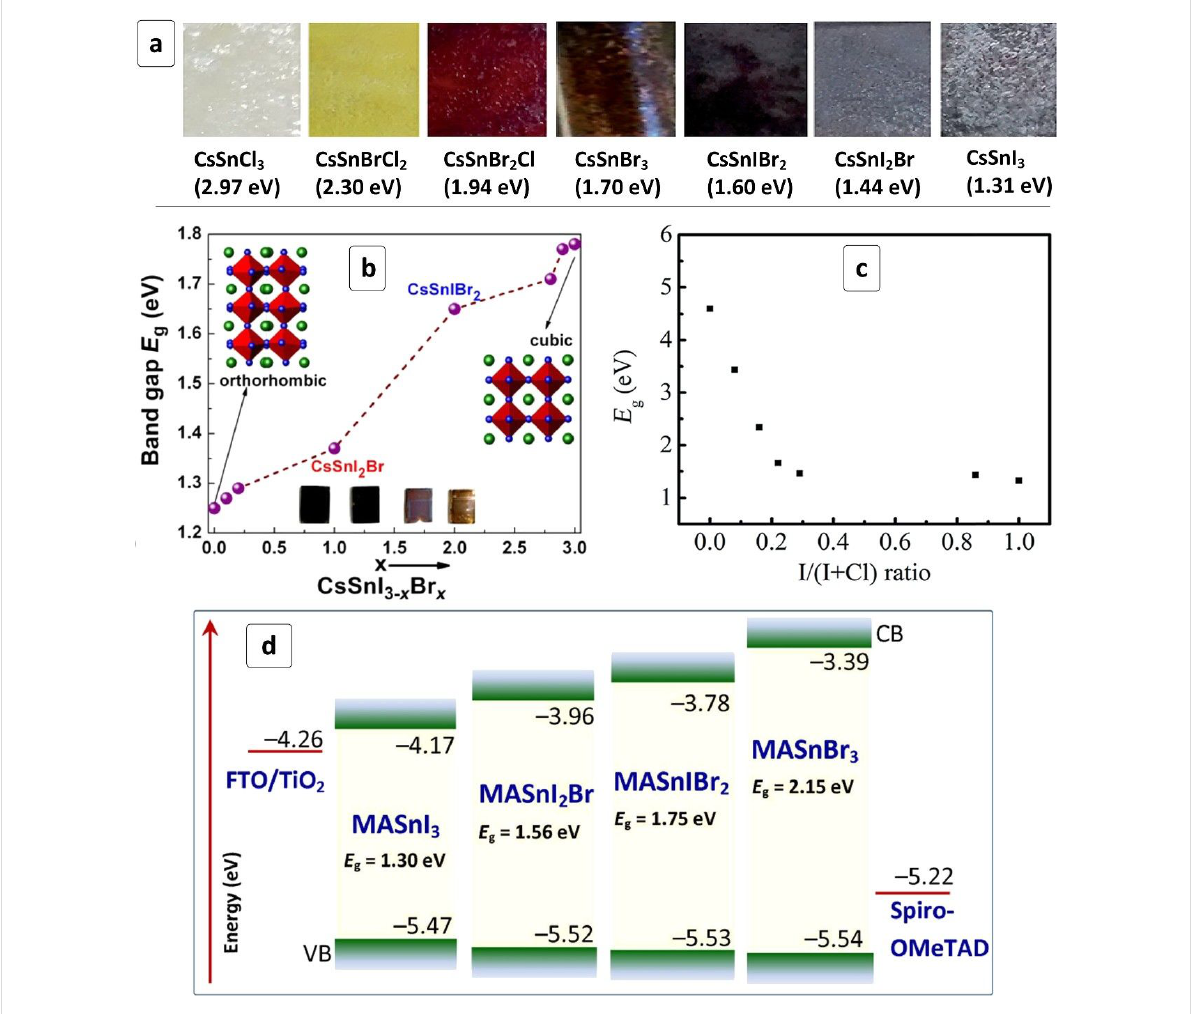
Figure 6: (a) Photographs of HP films produced from different CsSnI 3 − x Br x and CsSnBr 3 − x Cl 3 compounds (bandgaps are provided in parenthesis); (b,c) Bandgap as a function of the composition of CsSnI 3 − x Br x HPs (b) and Cs 2 SnI x Cl 6 − x HPs (c); (d) energy diagrams of solar cells based on MASnI 3 − x Br x HPs, FTO/TiO 2 ETL and Spiro-OMeTAD HTL. The diagram is plotted using numerical data reported in [74]. (a) Reprinted and adapted from [126], copyright 2016 The Royal Society of Chemistry; (b) Reprinted and adapted from [127], copyright 2015 American Chemical Society; (c) Reprinted and adapted from [128], copyright 2018 The Royal Society of